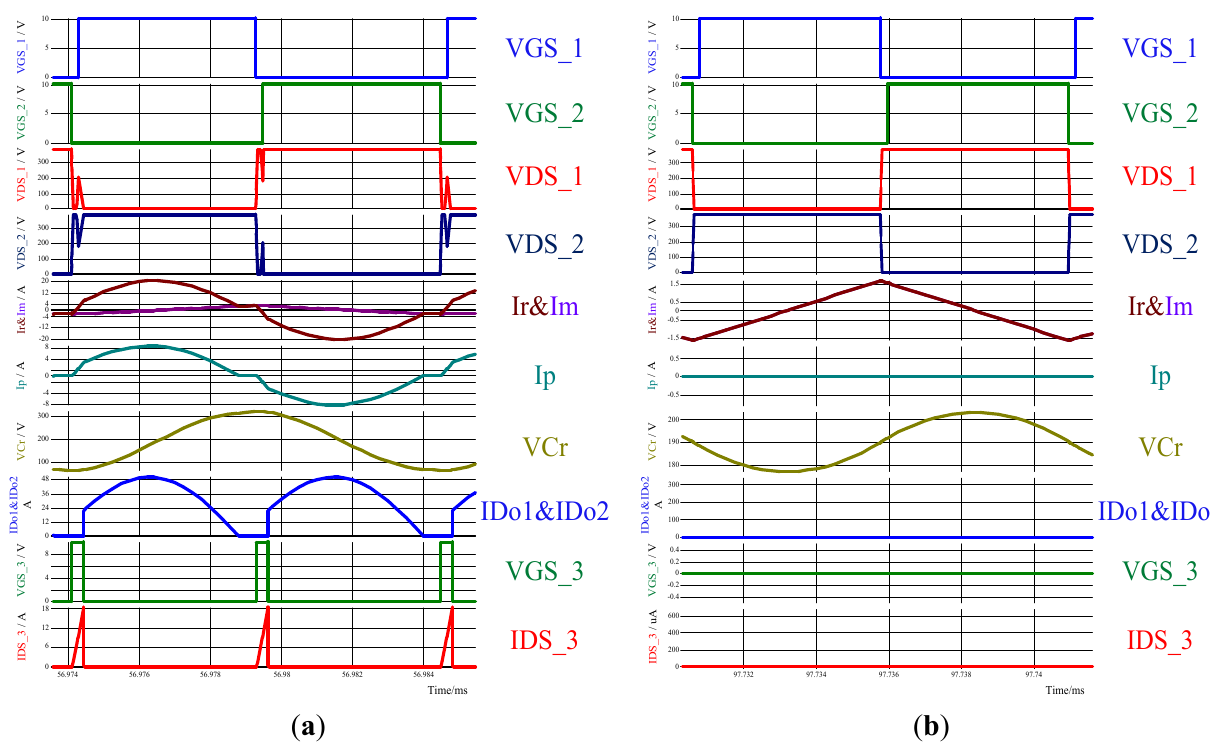
Figure 24. Simulated waveform for typical LLC control circuit under 1200 W/48 V: ( a ) 100% load; and ( b ) 0%